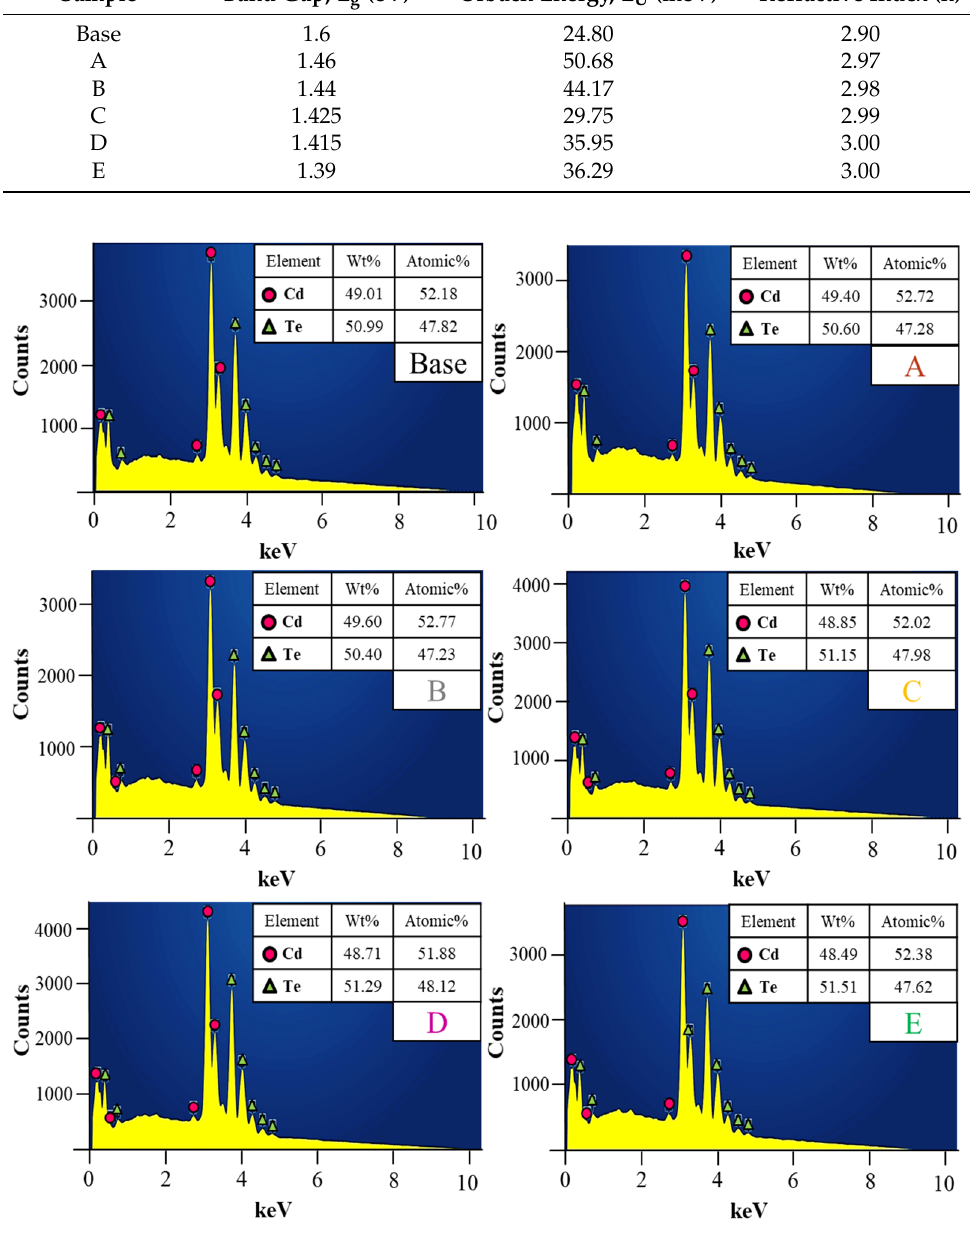
Figure 6. EDX spectra of CdTe thin films. Figure 7. EDX spectra of CdTe thin